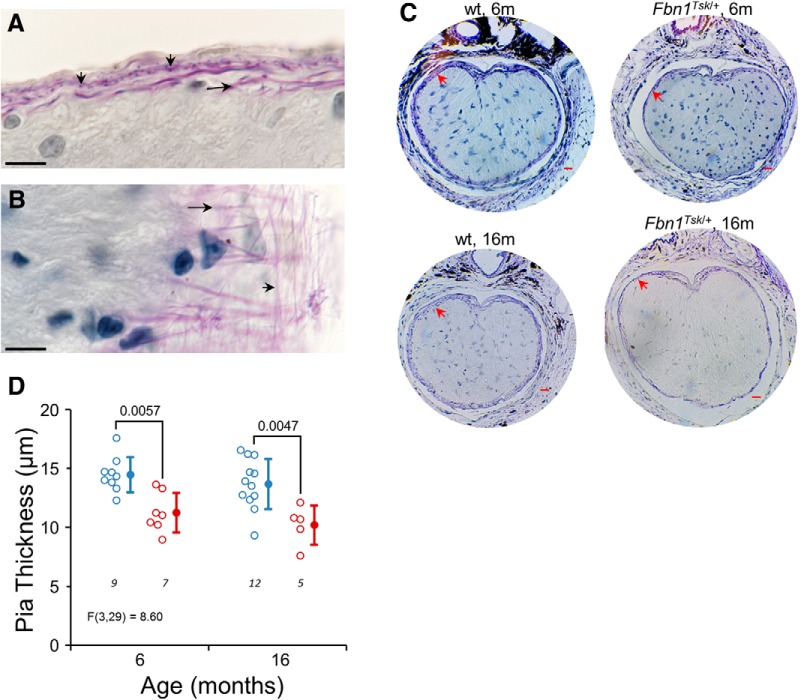
Thinning of the pia mater in Fbn1Tsk
/+ mice. Luna staining of longitudinal (A) and oblique sections (B) reveal an extensive elastic fiber network (purple staining) of the pia mater composed of longitudinal (long arrows) and radial fibers (short arrows). In Luna-stained cross sections of the optic nerve near the glial lamina, the pia matter (red arrows) appears thinner in Fbn1Tsk
/+ nerves as compared to wt at six and 16 months of age (C). Quantification of pia mater thickness shows significantly thinner pia mater in Fbn1Tsk
/+ optic nerves at six and 16 months of age (D; blue symbols, wt; red symbols, Fbn1Tsk
/+. Closed symbols, mean ± SD. Scale bars: 10 μm (black; A, B) and 20 μm (red; C). Numbers of nerves analyzed indicated in italics below each group (D).